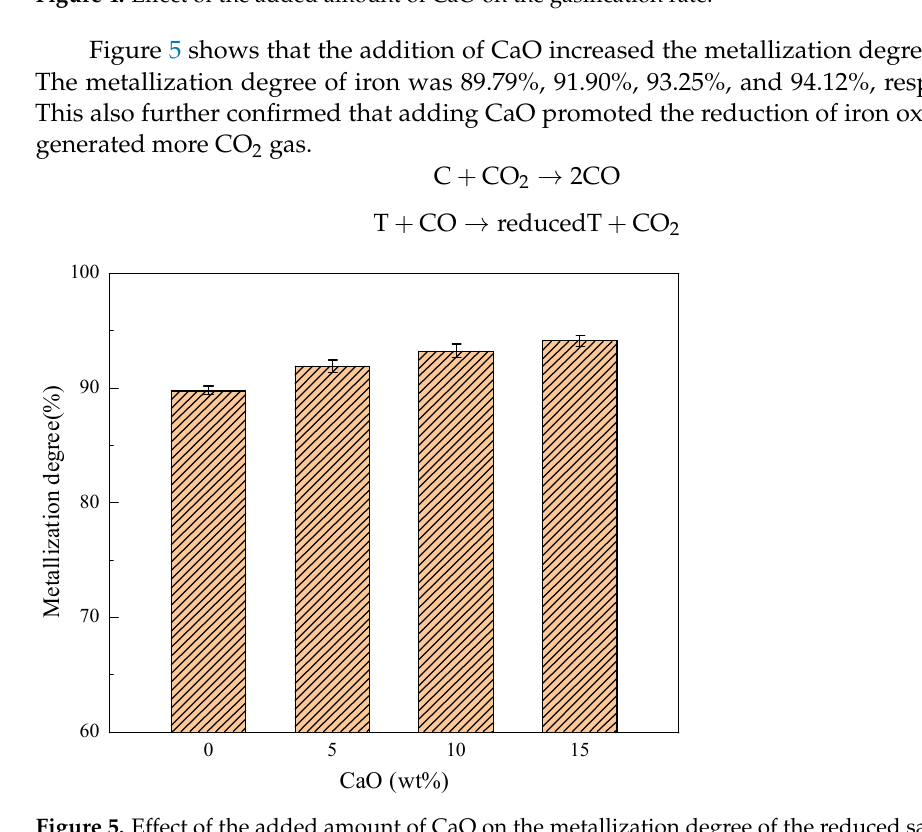
Figure 4. Effect of the added amount of CaO on the gasification rate.